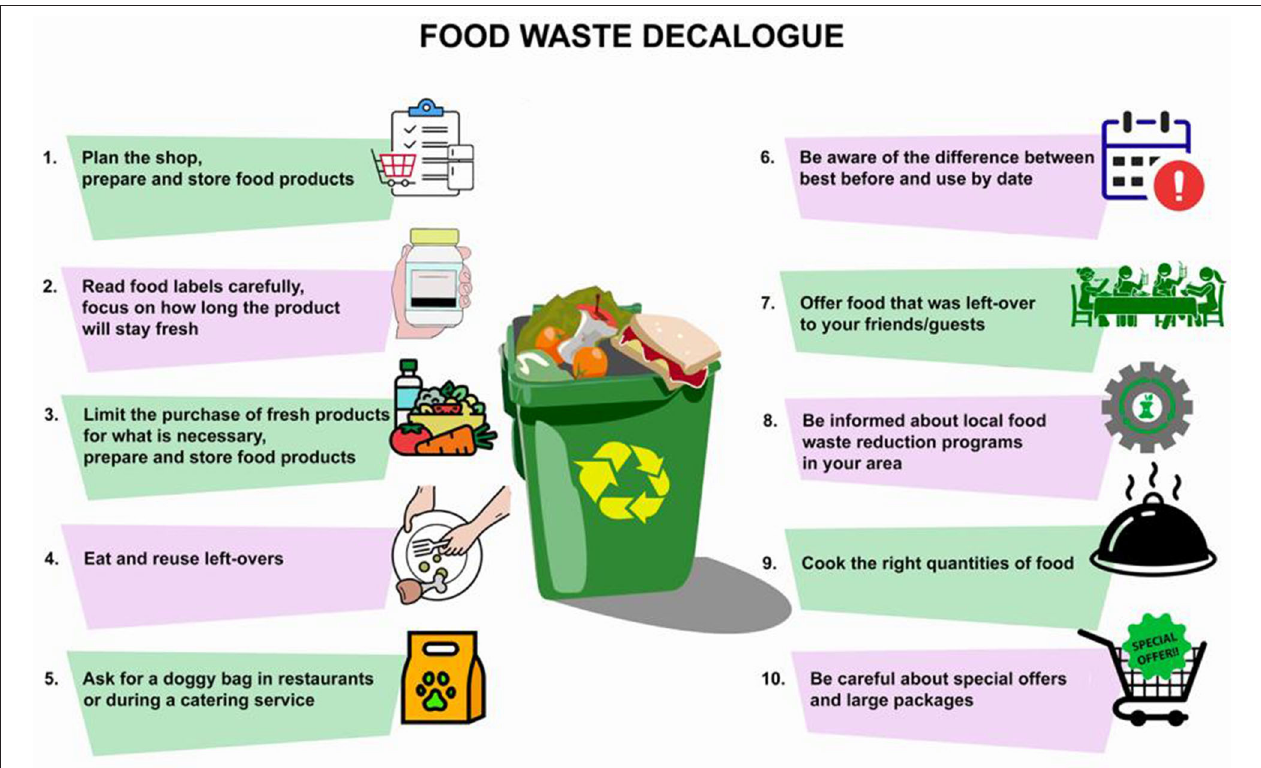
FIGURE 5 | The decalogue against food